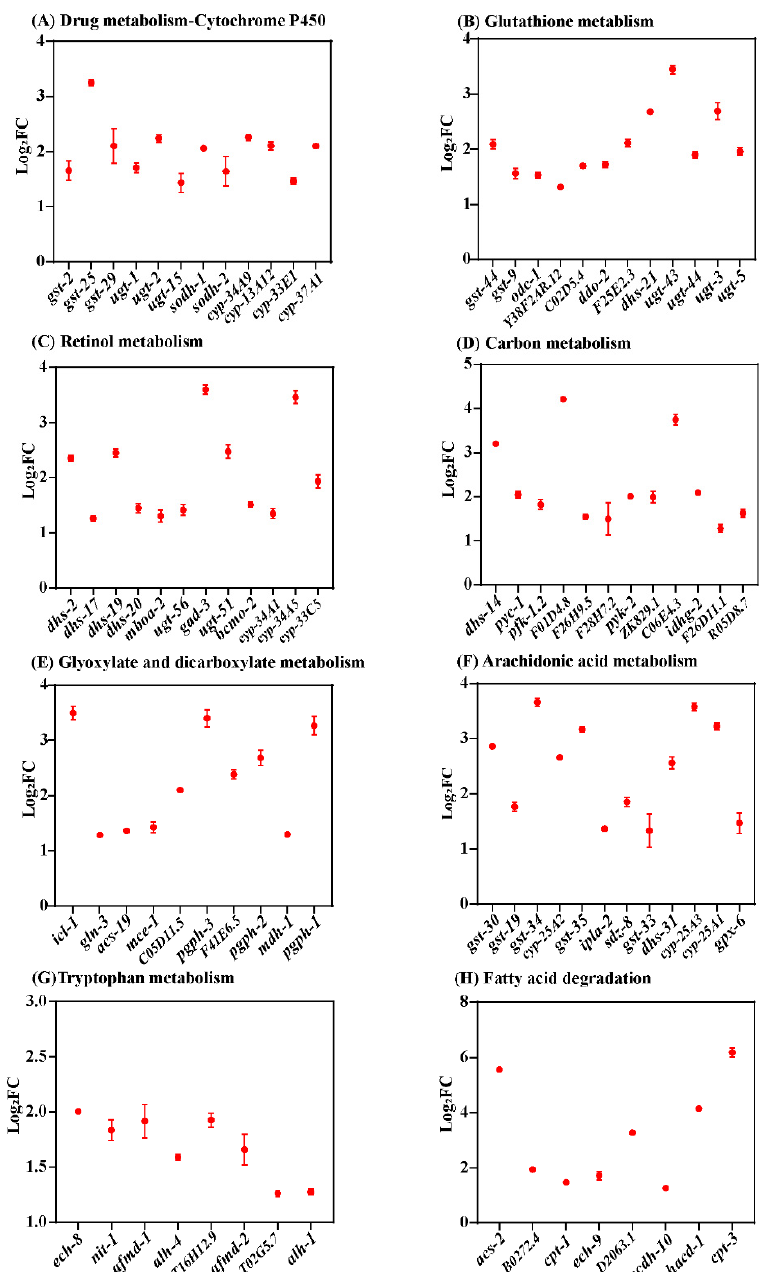
Figure 3. The expression of shared pathway related genes in C. elegans on CeMM. ( A ) Cytochrome P450-related genes in C. elegans . ( B ) Glutathione metabolism-related genes in C. elegans . ( C ) Retinol